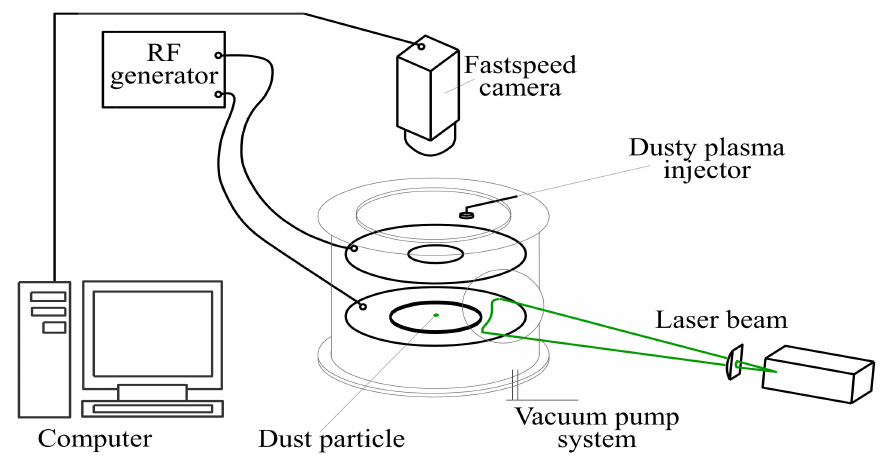
Figure 6. Scheme of the experimental